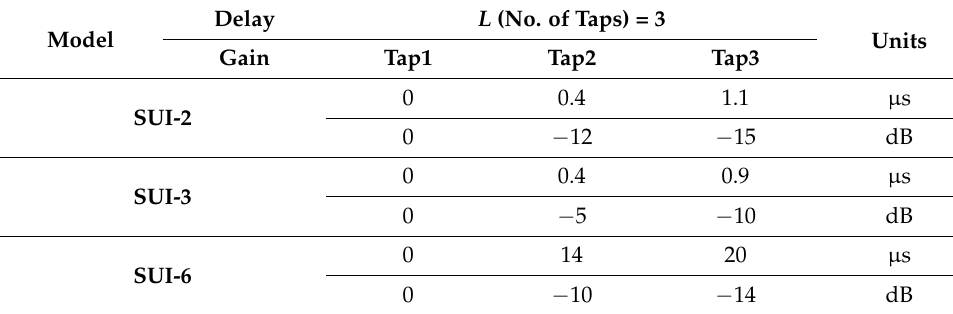
Table 3. The multipath profiles of the used SUI